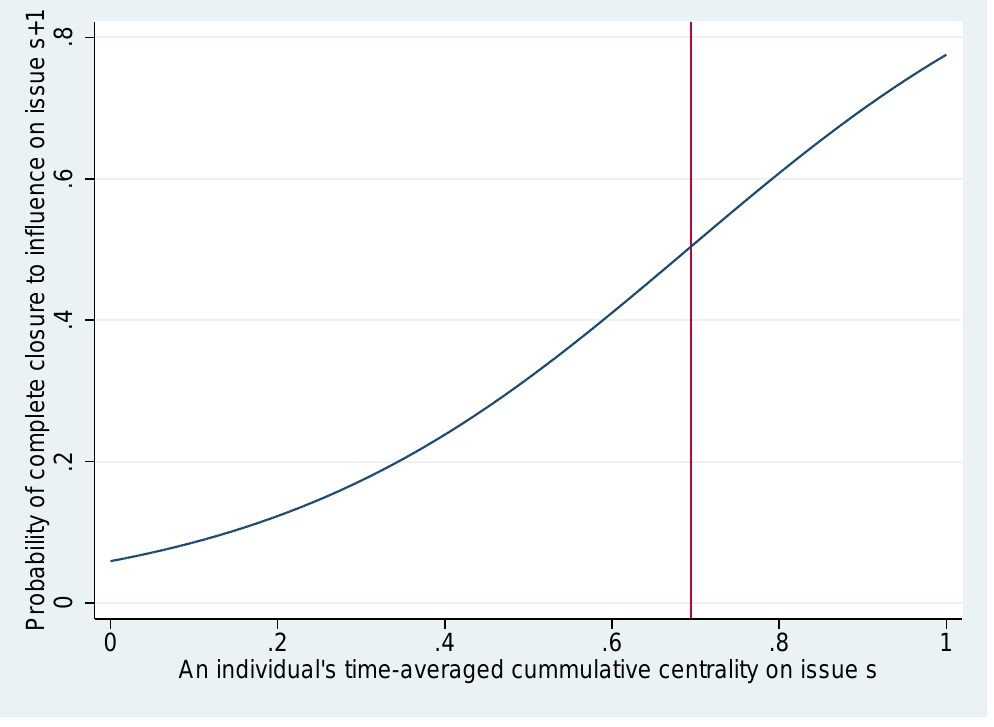
∑ s ( s ) = 1 Figure 6: Prior time-averaged centrality T C i ( t ) of individual i and the individual’s probability of i t = 1 s complete closure to influence a ii = 1 − w ii = 0 on issue s + 1. Balanced logistic random-intercept multilevel longitudinal design. Plot of estimated probabilities based on odds ratio estimates β 0 = 0.063 (s.e. = 0.018), p ≤ 0.001; β 1 = 54.798 (s.e. = 45.018), p ≤ 0.001. The vertical line indicates the maximum observed value of T i ( s ) in the